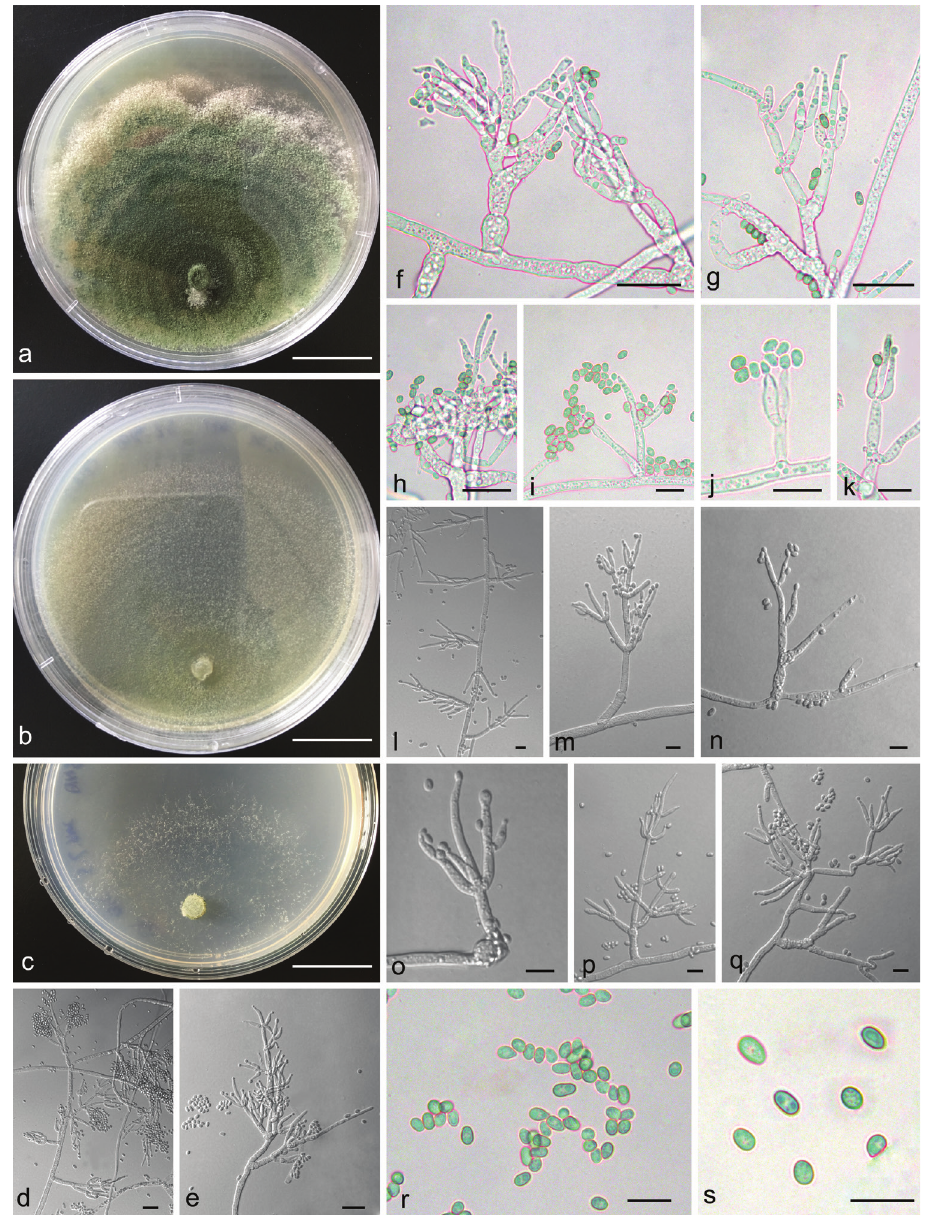
Figure 2. The new species Trichoderma fujianense , holotype (HMJAU 34830). a–s Asexual state a–c Cultures after 13 d at 25 °C ( a PDA, b CMD, c SNA). d–q Conidiophores and phialides (SNA, 20 d) r, s Conidia (SNA, 20 d). Scales bars: 20 mm ( a–c ); 20 μm ( d–h ); 10 μm ( i–s